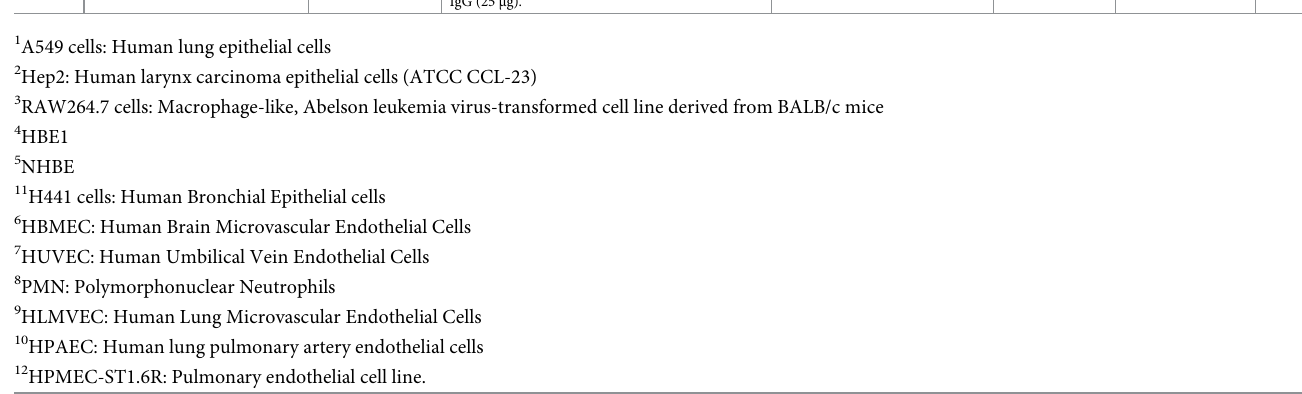
studies in the context of pneumonia.